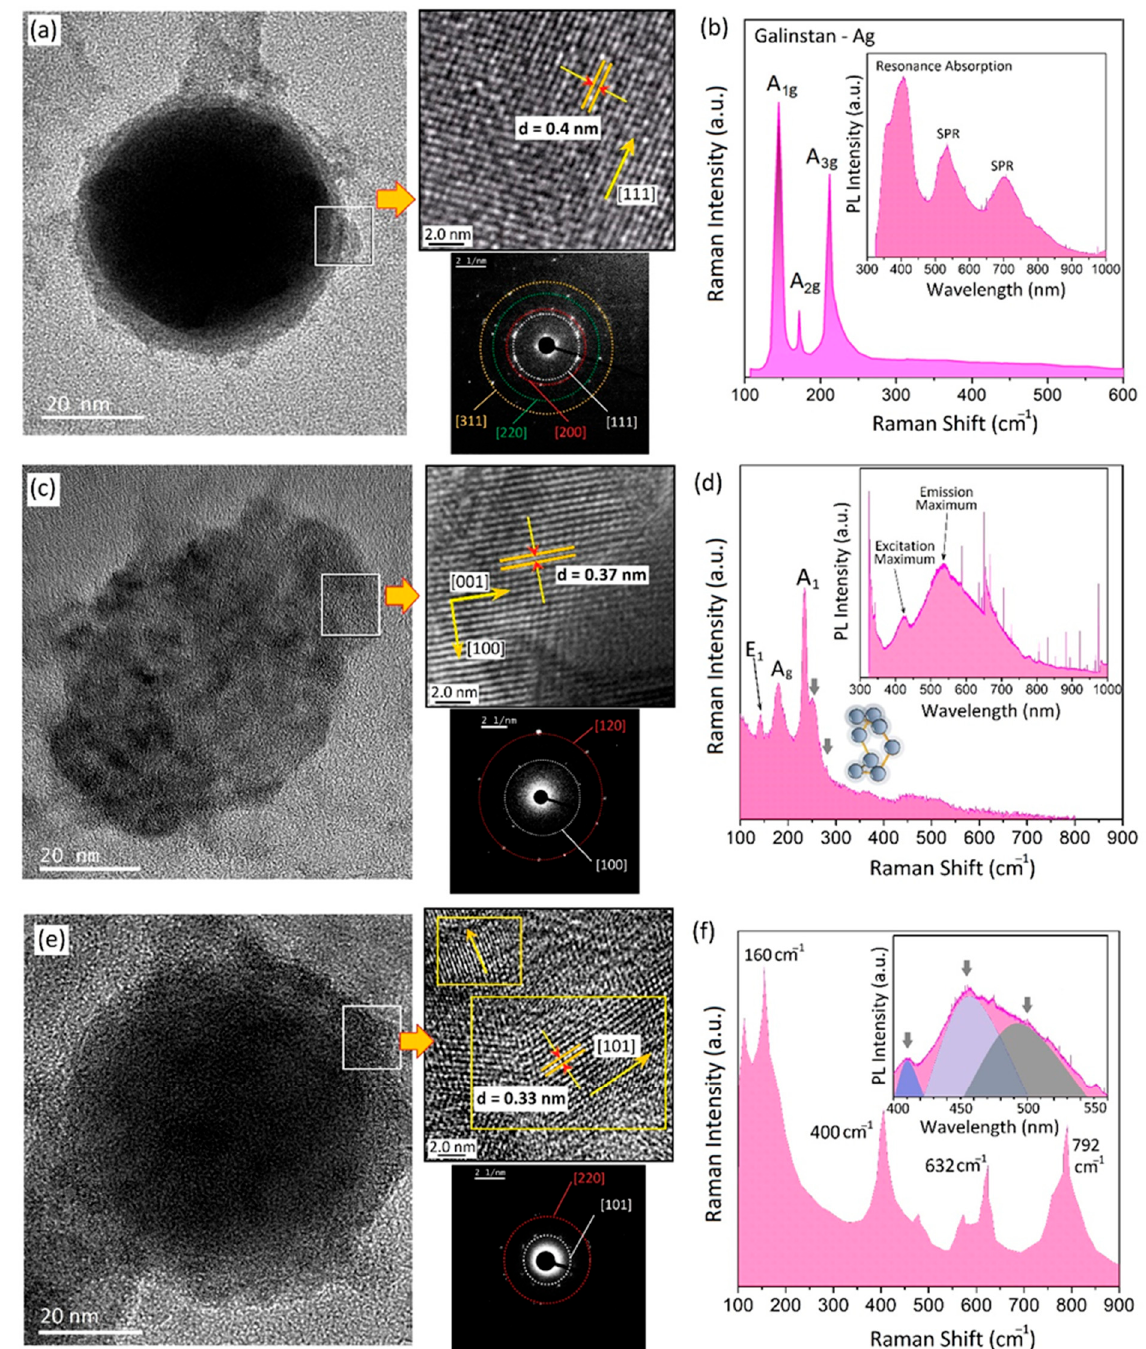
Figure 3. ( a ) The TEM image and corresponding SAED patterns of surface of galinstan NPs with Ag nanodomains. ( b ) The Raman and PL spectra of galinstan-Ag NPs. ( c ) The TEM image and corresponding SAED patterns of surface of galinstan NPs with Se nanodomains. ( d ) The Raman and PL spectra of galinstan-Se NPs. ( e ) The TEM image and corresponding SAED patterns of surface of galinstan NPs with Nb nanodomains. ( f ) The Raman and PL spectra of galinstan-Nb NPs.